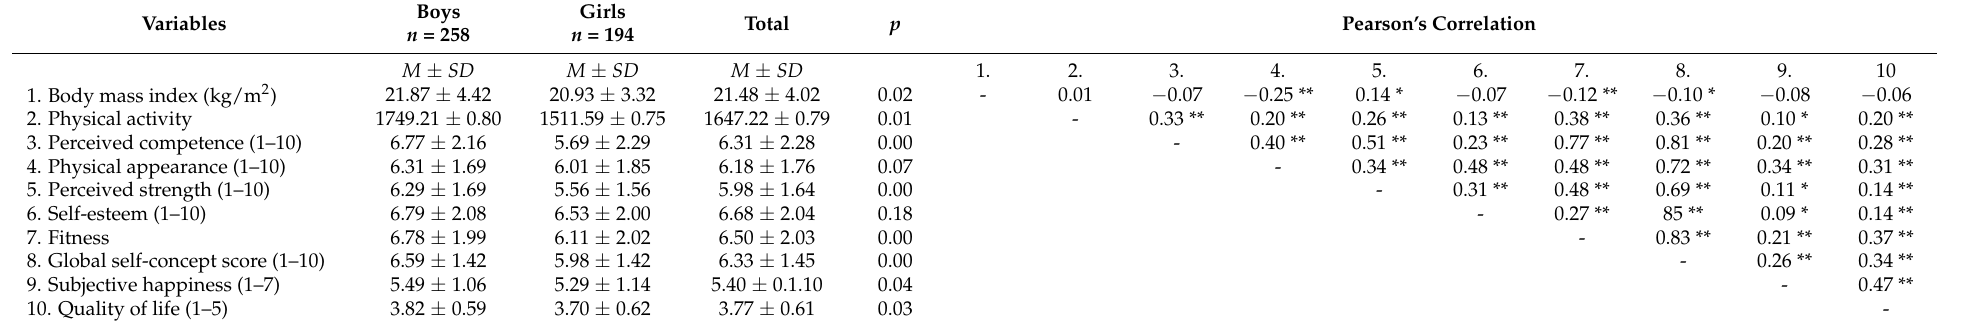
Table 1. Descriptive statistics and correlation analysis between the study